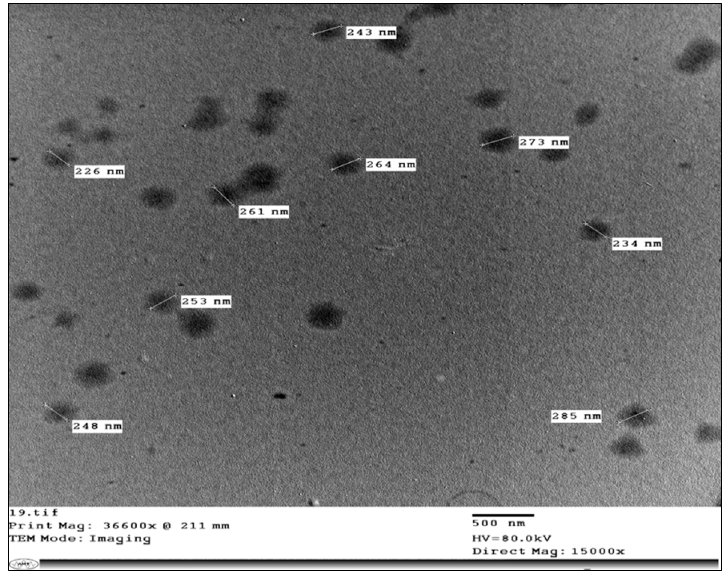
Figure 6. Transmission electron micrograph of